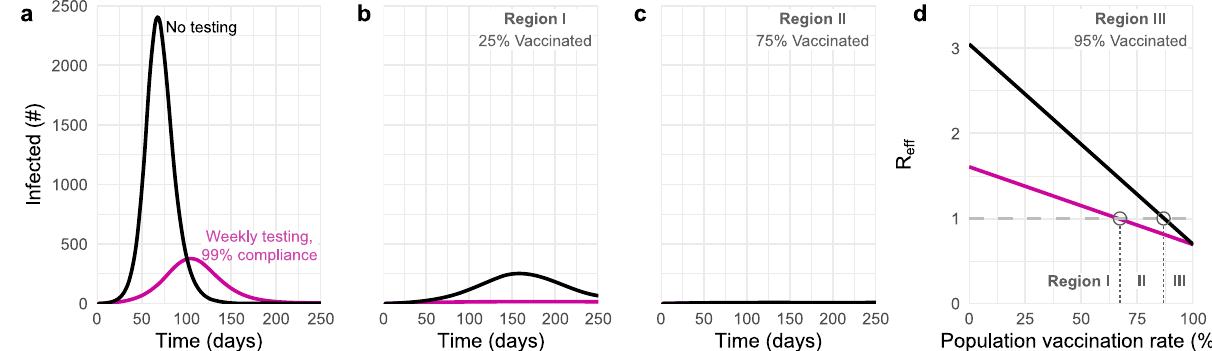
Fig. 4 The impact of unvaccinated-only screening corresponds to three distinct parameter regions. Total number of infections with no screening (black) and weekly testing with 99% compliance (pink) are shown for a 25%, b 75%, and c 95% population vaccination rates. d Effective reproductive number over various population vaccination rates, where R eff = 1 is denoted by gray dashed line. The impacts of screening fall into three categories (see text) depending on whether vaccination rate falls into region I, II, or III, as annotated. R NPI ¼ 4 and 35% rate of prior infection with baseline immunity 0 parameters (Materials and Methods, Supplementary Table 2).